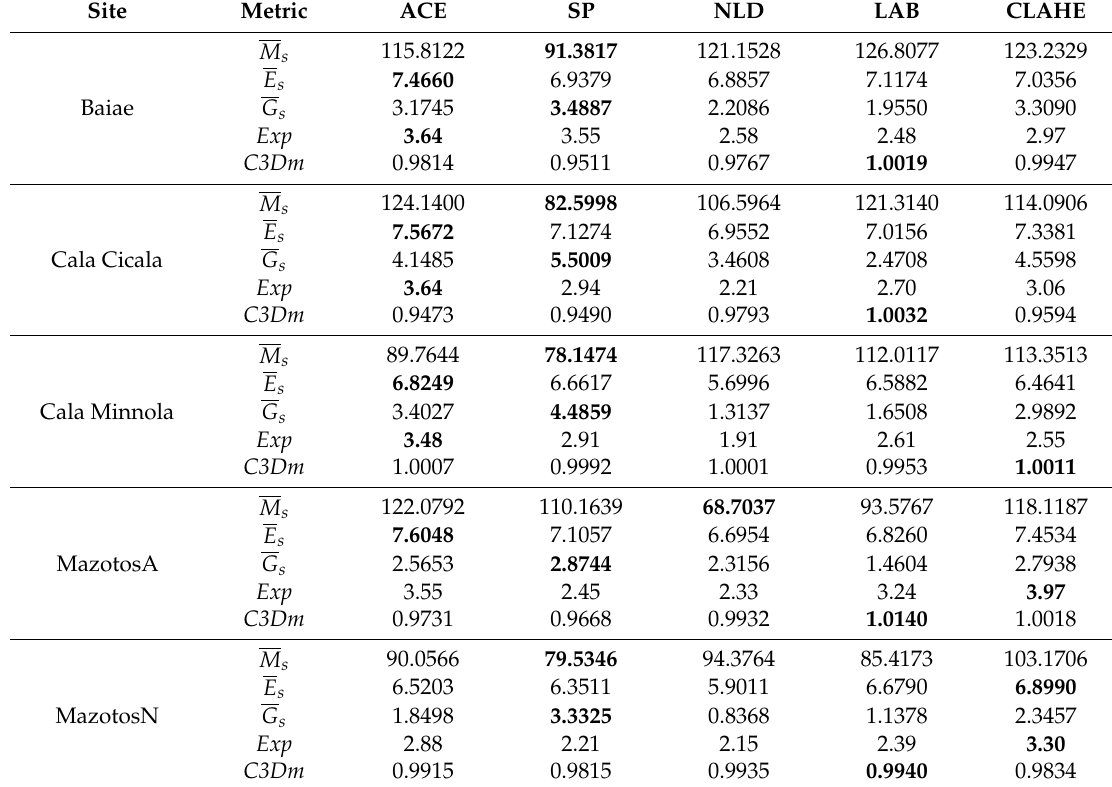
Table 12. Average metrics and average expert votes calculated for each